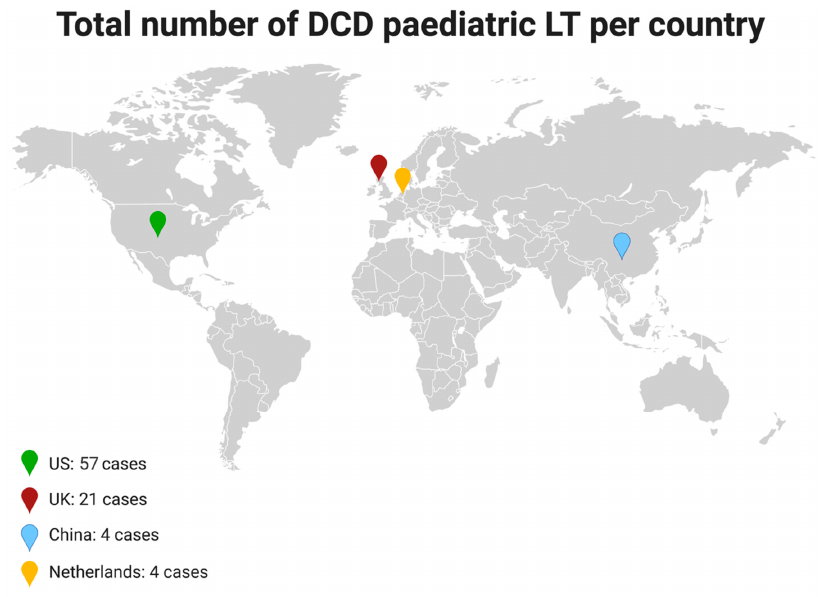
Figure 1. Total number of DCD paediatric LT per reported